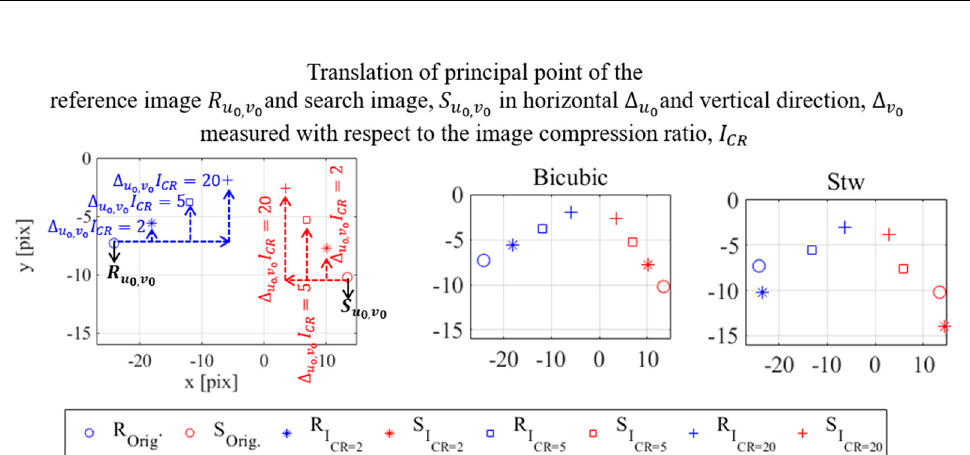
Figure 10. Principal points u 0 , v 0 location in the input image plane and their translation in the compressed image plane for different compression methods and ratios. The examples are shown for the bicubic interpolation and STW compression methods. Table 2. Photogrammetry results using 76 images with original size of 2560 × 2048 pixels. Internal Parameters